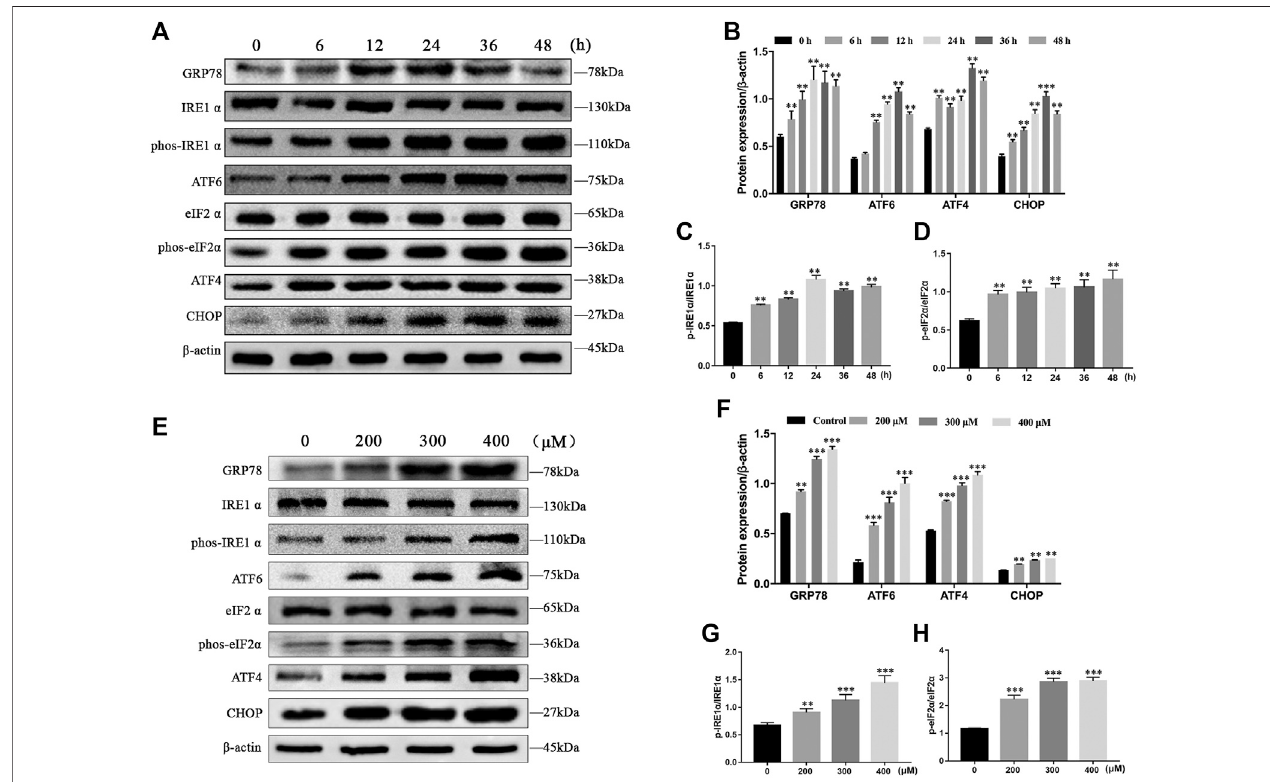
FIGURE 3 | MCT induced ER stress in primary rat hepatocytes. (A) Representative immunoblot against ER stress-related proteins from hepatocytes treated with 300 μ MofMCTfor6,12,24,36,and48 h. (B – D) QuantitativeanalysisofproteinlevelsinA. (E) RepresentativeimmunoblotERstress-relatedapoptosis-relatedproteins from hepatocytes treated with different doses of MCT (200, 300, and 400 μ M) for 36 h. (F – H) Quantitative analysis of protein levels in E. β -actin served as a loading control. Data are presented as mean ± SD error of three independent experiments. * p < 0.05, ** p < 0.01 compared to control.